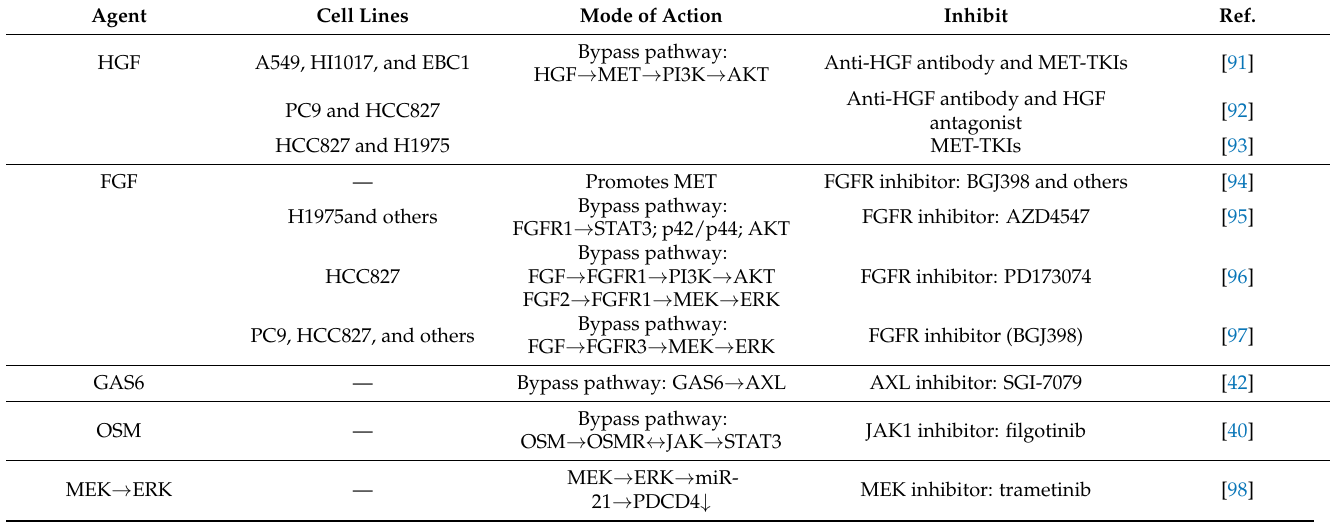
Table 1. Cancer-associated fibroblasts mediate resistance to tyrosine kinase inhibitors